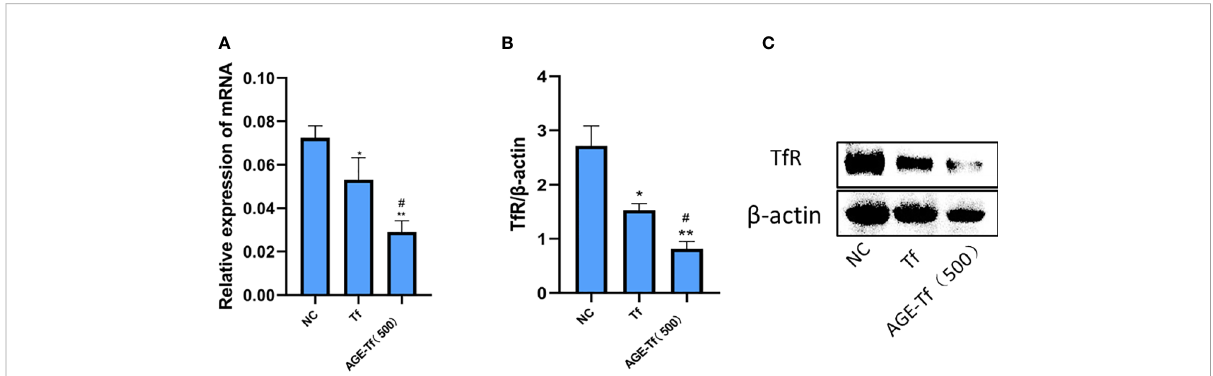
FIGURE 6 Effect of AGE-Tf on TfR expression level of HK-2 cells. (A) TfR mRNA analysis. (B) Gray-scale analysis of TfR protein expression. (C) TfR protein expression. Compared with the NC group, *p < 0.01, **p < 0.001. Compared with the Tf group, # p < 0.05; AGE-Tf (500): the glucose concentration was 500 mM when preparing